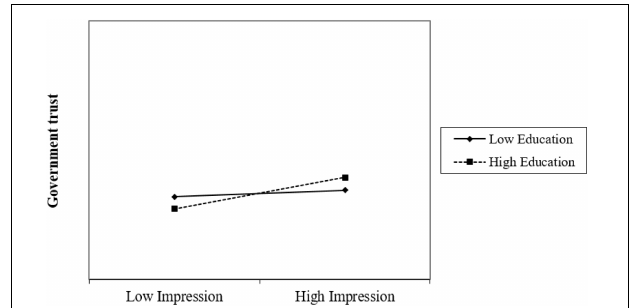
TABLE 2 | Analysis of the mediating effect.